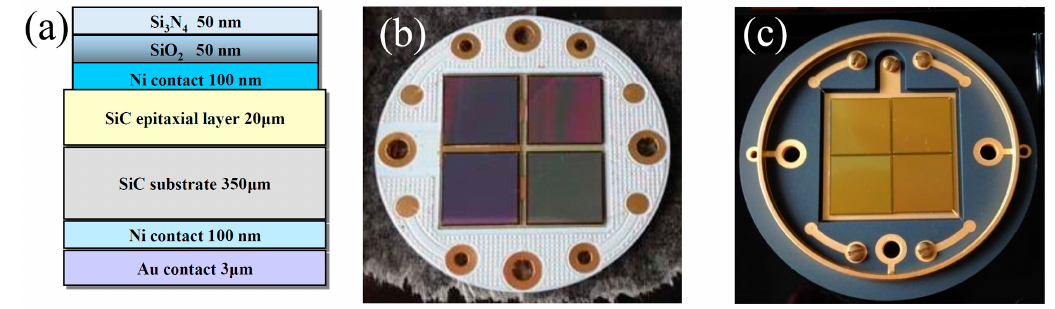
Figure 1. ( a ) Schematic diagram of a 4H-SiC Schottky diode detector; photograph of a 4H-SiC detector in a 2 × 2 array mounted on a multi-layer PCB plate ( b ) and in a ceramic case ( c ) with a total sensitive area of 4 cm 2